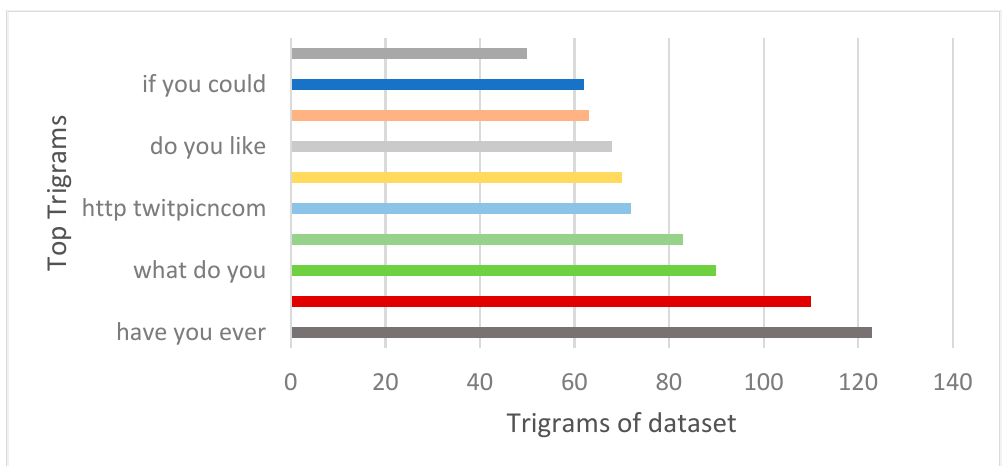
Figure 10. Trigrams of Dataset.